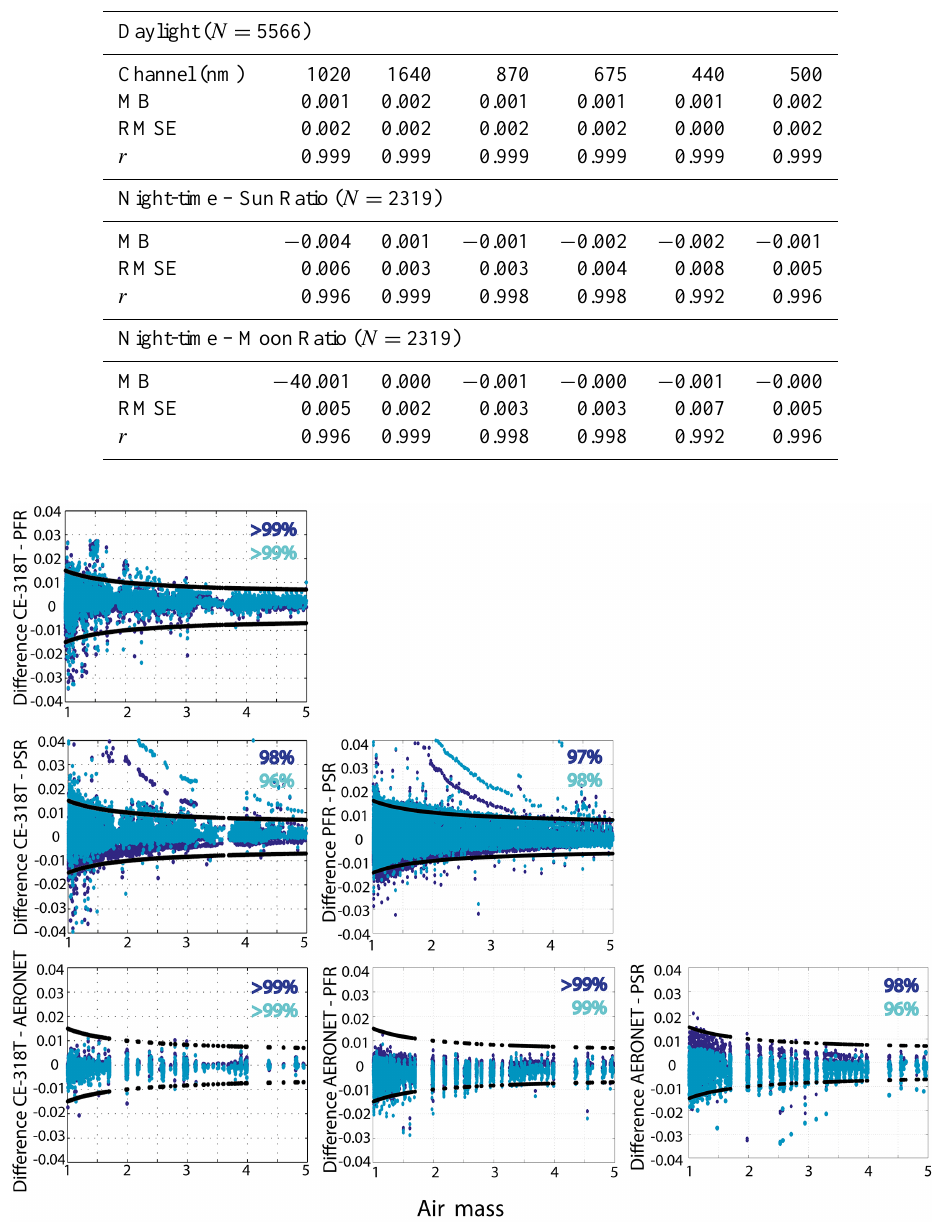
Figure 6. AOD differences vs. air mass for the channel centred at 870nm (blue) and 500nm (cyan). The solid line represents the U 95 uncertainty limit. In each figure panel, the percentage of points within the U 95 limits is